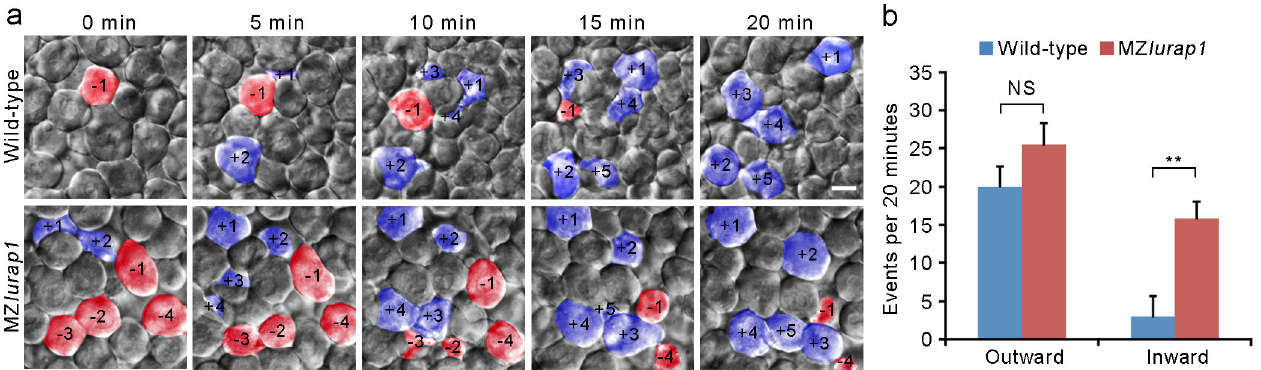
Figure 4. Defective radial intercalation of DEL cells in MZ lurap1 mutant embryos. ( a ) Still frames from representative time-lapse imaging of DEL cell movements in the animal pole region of wild-type and MZ lurap1 mutant embryos at 50% epiboly. The focal plane was set at the outermost layer of the DEL immediately underlying the EVL. Cells undergoing outward movements are fake color labeled blue, and are attributed with positive numbers, while cells undergoing inward movements are labeled red, and are attributed with negative numbers. Scale bar: 10 µ m. ( b ) Statistical analysis compares inward and outward movements in the same focal plane during a period of 20 min. The results were analyzed independently in a blended manner. Data were collected from 5 embryos for each group in three independent experiments. Bars represent the mean value ± s.d. (NS, not significant; **, p <